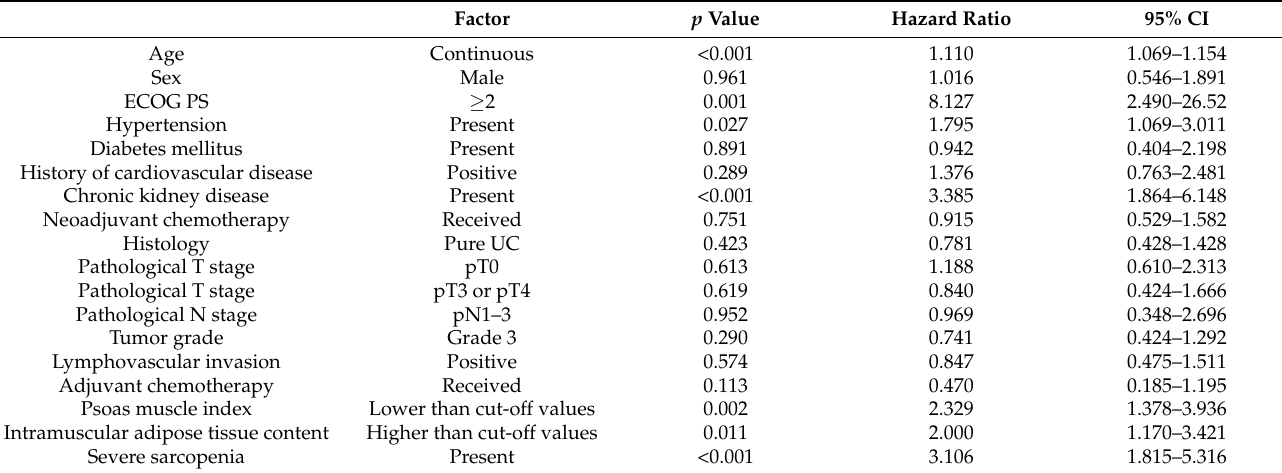
Figure 5. Non-cancer-specific survival. The 5-year ( A ) and 10-year ( B ) non-cancer-specific mortality rates were compared between the control and severe sarcopenia groups using the chi-squared test. Non-cancer-specific survival after a 5-year cancer-free period were evaluated using the Kaplan–Meier method and compared using the log-rank test between patients with higher and lower psoas muscle index (PMI) values ( C ), lower and higher intramuscular adipose tissue content (IMAC) values ( D ), and patients in the control and severe sarcopenia groups ( E ). Table 2. Univariable analyses for non-cancer-specific survival.